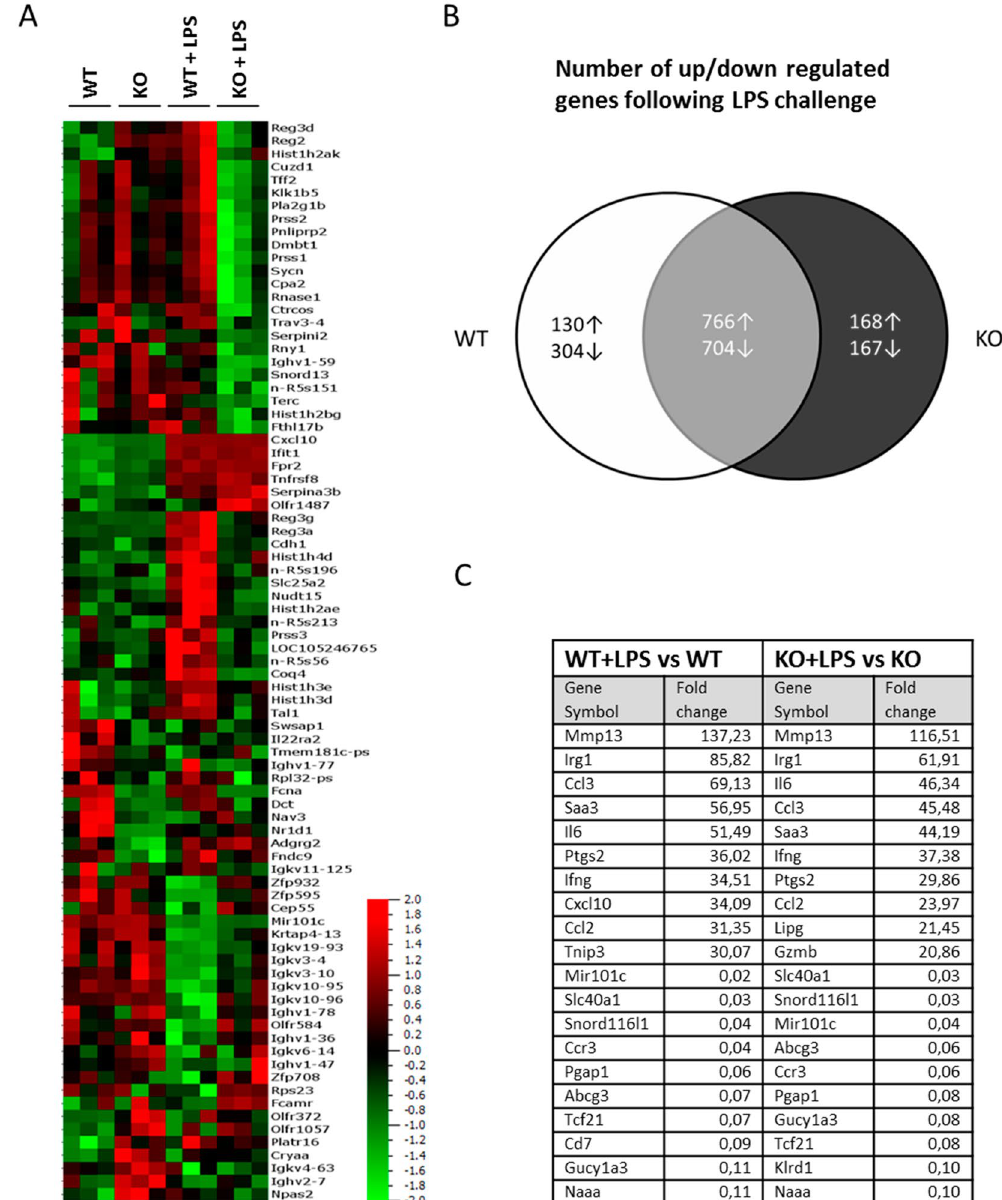
Figure 9. Microarray analysis of differentially expressed genes in WT and ficolin KO mice after LPS challenge. Groups of WT and ficolin KO mice were untreated or intraperitoneally injected with LPS of a lethal dose (10 mg/kg) and sacrificed after 6 h (n = 3 mice per group). Total RNA extracted from spleens was hybridized to the Affymetrix GeneChip Mouse Genome 2.0 ST arrays chip. ( A ) Heatmap showing all experimental samples and 85 genes found as differentially expressed between WT and KO mice in either naive or LPS-challenged state (cut-off: fold-change > 1.5 and p < 0.05). Samples are ordered by the four experimental groups and variables order by hierarchical clustering. ( B ) Venn diagram showing the number of differentially expressed genes induced by LPS challenge (cut-off: fold-change > 2.0 and q < 0.05). The white area contains the number of genes that were only affected in WT mice upon LPS challenge; the black area contains the number of genes that were only affected in ficolin KO mice upon LPS challenge; the grey area contains the number of overlapping genes between WT and ficolin KO mice that were affected upon LPS challenge. ( C ) Table showing the top 20 most changed genes (10 up and 10 downregulated) after LPS challenge in WT and ficolin KO mice (cut-off: fold- change > 2.0 and q <